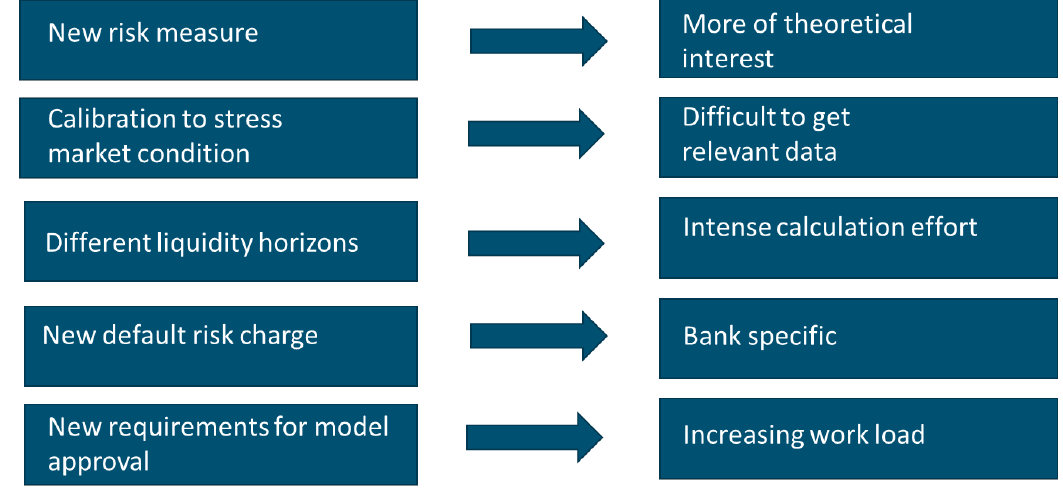
Figure 3. Requirements and their